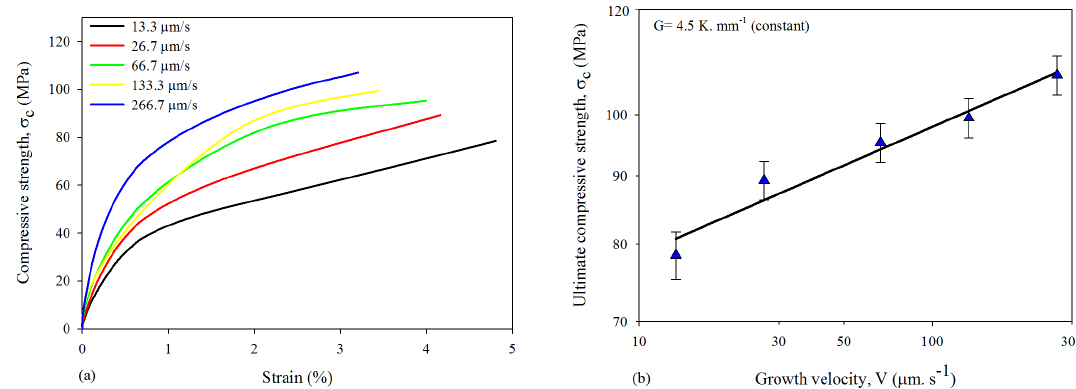
Figure 7. (a) Compressive strength-strain curve (b) the variation of ultimate compressive strength with growth velocity at a constant temperature